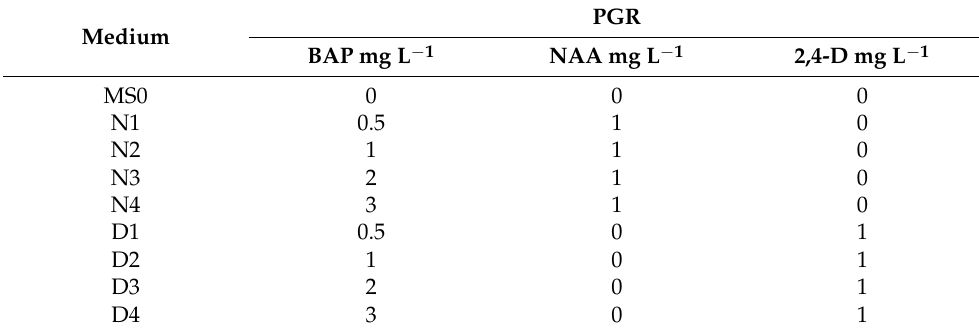
Abbreviations: MS0 (control, hormone-free, medium with sucrose); N1, (medium with 0.5 mg L − 1 BAP + 1 mg L − 1 NAA); N2 (1 BAP + 1 NAA); N3 (2 BAP + 1 NAA); N4 (3 BAP + 1 NAA); D1 (medium with 0.5 mg L −